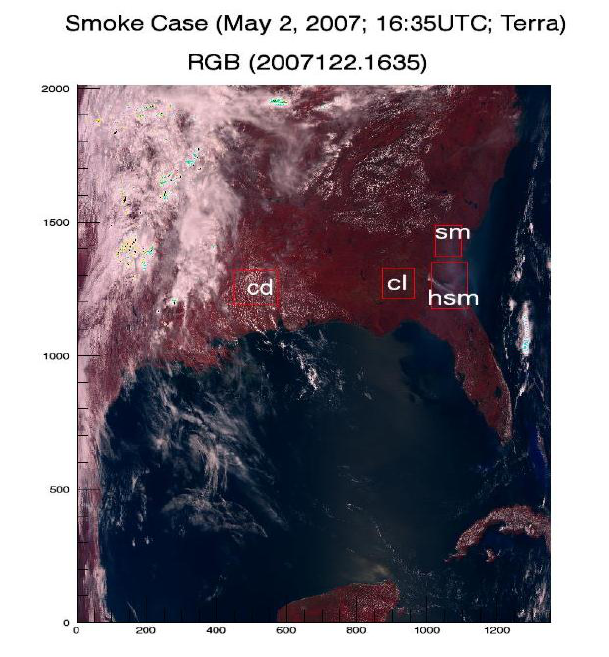
Figure 9. Terra MODIS RGB image for a granule with smoke plume over Georgia. Four rectangle regions influenced, respectively, by cloud (cd), clear-sky (cl), smoke (smoke), and heavy-smoke (hsm) are selected for sensitivity